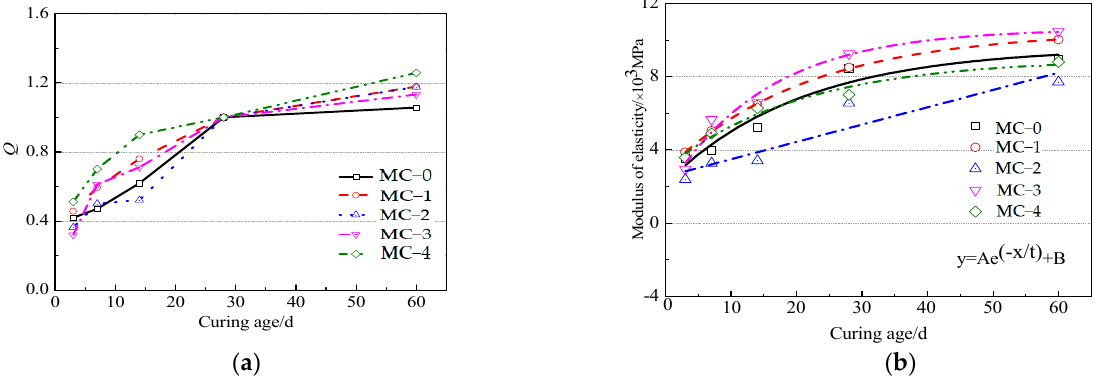
Figure 8. Relationship between compressive strength and curing age. ( a ) W; ( b ) R c . The relationship between the NCM elastic modulus, and the 28-day elastic modulus ratio Q and the curing age, and the relationship between the elastic modulus and age are shown in Figure 9. From Figure 9a, it can be seen that the elastic modulus of NCM in each group increases according to age, and the strength increases rapidly before 7 days. This is attributed to the fact that a large number of hydration products are generated before the 7-day curing age. With the generation of hydration products, the hardened cement paste forms a dense solid, which accelerates the improvement of the strength of the cement mortar [26,27]. The elastic modulus ratio of cement mortar under 7 days and at 28 days curing is 47.0%, 59.4%, 50.0%, 61.2%, and 70.0%, respectively. This indicates that the dispersion of nanoclay particles increases the elastic modulus growth rate of cement mortar and improves its early toughness. Figure 9b shows that the elastic modulus of NCM increases exponentially with age, and the growth rate of elastic modulus of NCM decreases with the increase in age. The growth rate of the early elastic modulus of NCM is NMK > ordinary cement mortar > NMA. After 14 days, the growth rate is the same. The strong growth rate of the elastic modulus in NCM gradually slows down after 7 days, and the growth law is the same as that for compressive strength, but the growth rate is low.